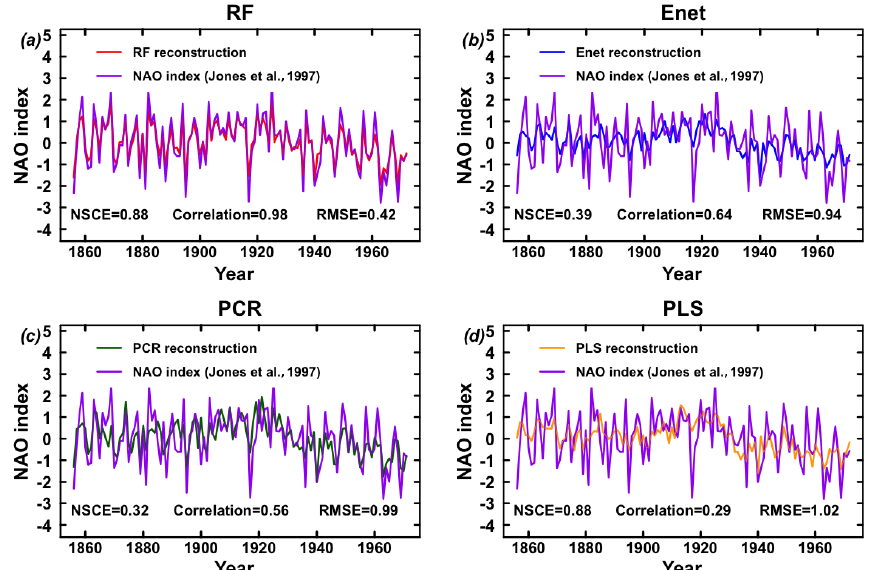
Figure 8. Comparison of reconstructions from this study with the original Jones et al. (1997) NAO index (purple line) over their common pe- riod. (a) RF reconstruction. (b) Enet reconstruction. (c) PCR reconstruction. (d) PLS reconstruction. NSCE, RMSE and correlation statistics are provided.